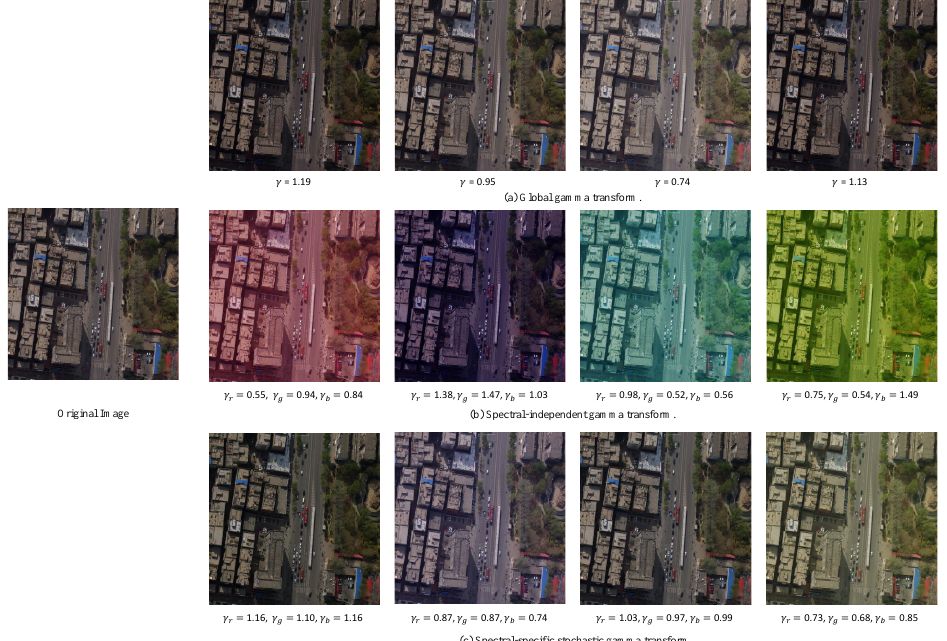
Figure 6. Results of different data augmentation methods based on global gamma transform (GGT), spectral-independent gamma transform (SIGT), and our spectral-specific stochastic gamma transform